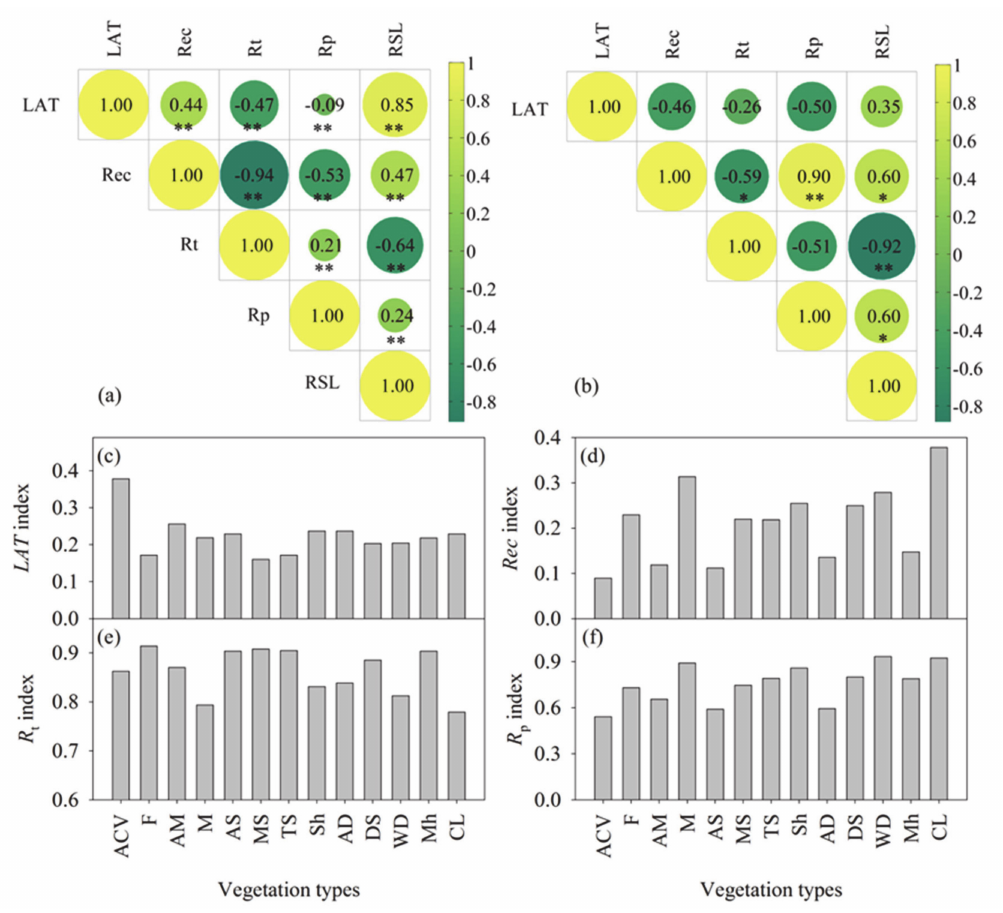
Figure 2. The correlation between the index of different aspects of ecosystem resilience and their values on different vegetation types: ( a , b ) are the correlation of each index on the scale of pixel and vegetation type, respectively. The symbol ‘**’ and ‘*’ in ( a , b ) indicates the extremely significant correlation and significant correlation, respectively. Panel ( c – f ) shows the latitude of resilience ( LAT ), recovery rate ( Rec ), and the resistance of ecosystem to temperature ( R t ) and precipitation ( R p ) on vegetation type scale. ACV stands for alpine cushion vegetation, F stands for forest, Sh stands for shrub, M stands for meadow, AM stands for alpine meadow, AS stands for alpine steppe, MS stands for meadow steppe, TS stands for typical steppe, DS stands for desert steppe, AD stands for alpine desert, WD stands for warm desert, Mh stands for marshland, and CL stands for cultivated